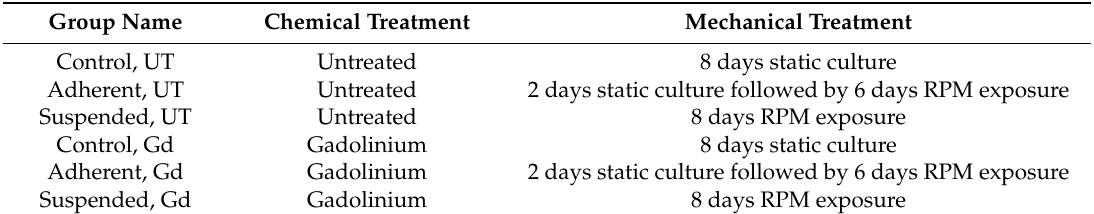
Table 1. Experimental groups. Chondrocytes were distributed to six experimental groups, exposing them to either static cell culture, static culture followed by RPM exposure or RPM exposure only. The medium was additionally supplemented with 20 mM gadolinium or left untreated.